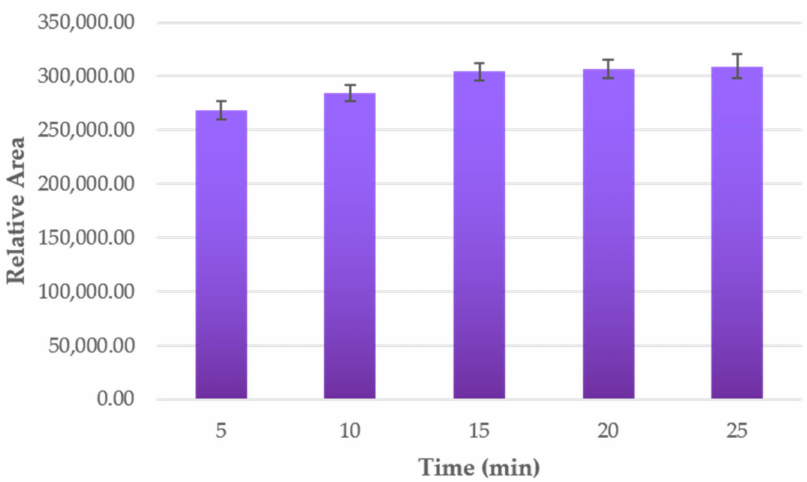
Figure 4. Anthocyanins’ relative area according to the different extraction times ( n =